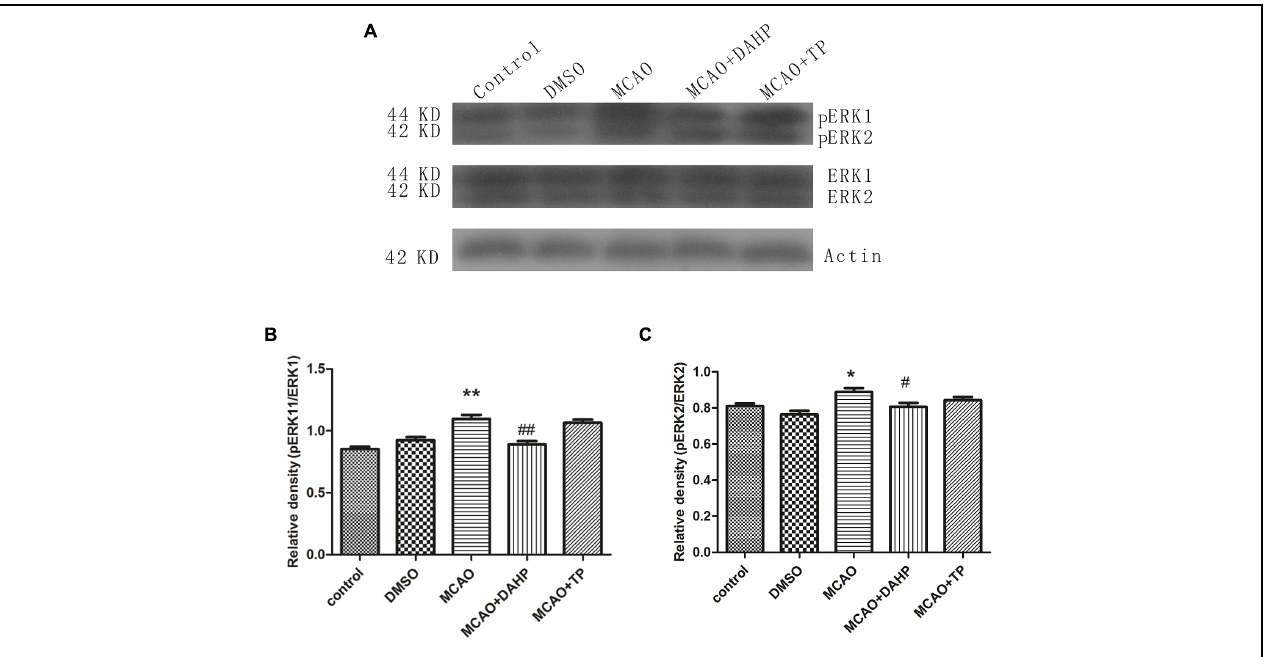
FIGURE 8 | 2, 4-diamino-6-hydroxypyrimidine and TP treatment attenuated the increasing expressions of pERK1/ERK1 and pERK2/ERK2. (A) The expressions of pERK1/ERK1 and pERK2/ERK2 were increased in MCAO group compared to control group. DAHP and